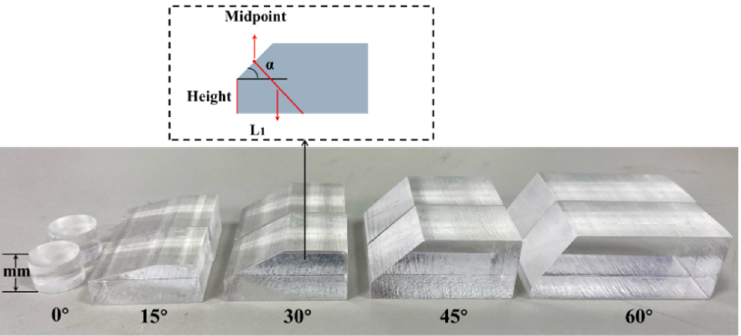
Figure 4. Physical images of PMMA wedges.